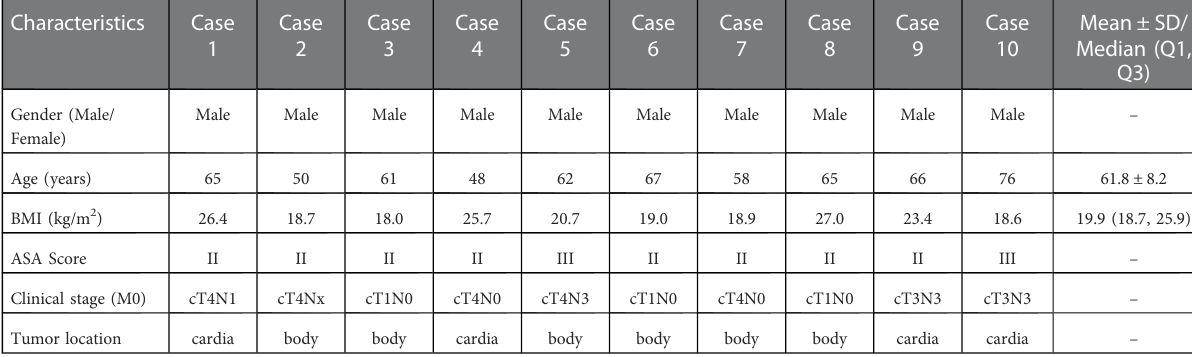
TABLE 1 Patients ’ basic information and clinical characteristics of tumor.